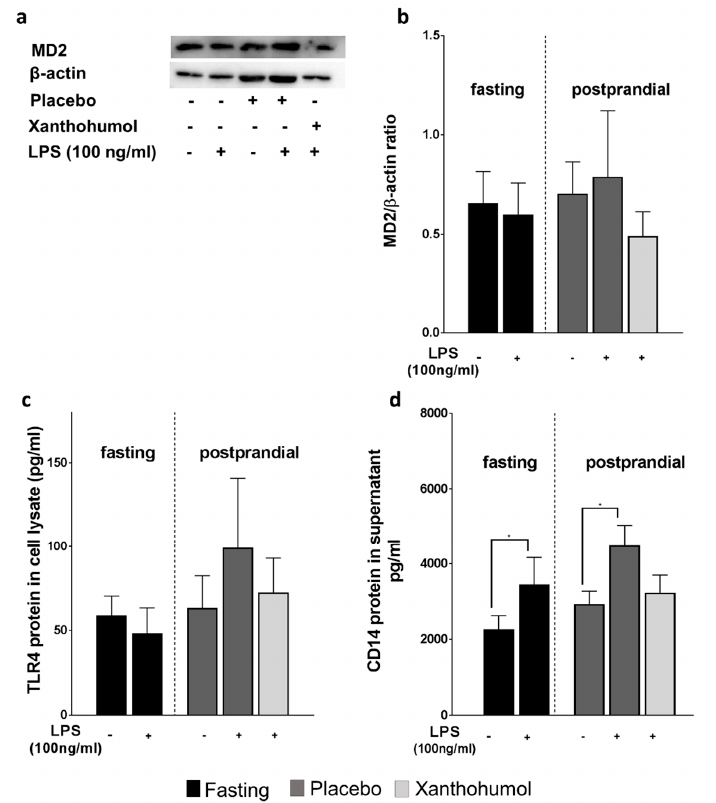
Figure 4. Protein concentration of MD − 2, TLR4 and CD14 in LPS − stimulated PBMCs obtained from healthy study participants. Representative blots ( a ) and densitometric analysis of MD − 2 western blot ( b ), TLR4 protein concentration in total protein lysate ( c ) and sCD14 protein concentration in cell culture supernatant ( d ) of PBMCs obtained from study participants either receiving a placebo or XN stimulated with LPS (100 ng/mL) for 6 h. LPS, lipopolysaccharide; MD − 2, myeloid differentiation factor 2; PBMC, peripheral blood mononuclear cell; sCD14, soluble cluster of differentiation 14; TLR, toll − like receptor; XN, xanthohumol derived through a XN − rich hop extract. Data are expressed as means ± SEM. * = p < 0.05.